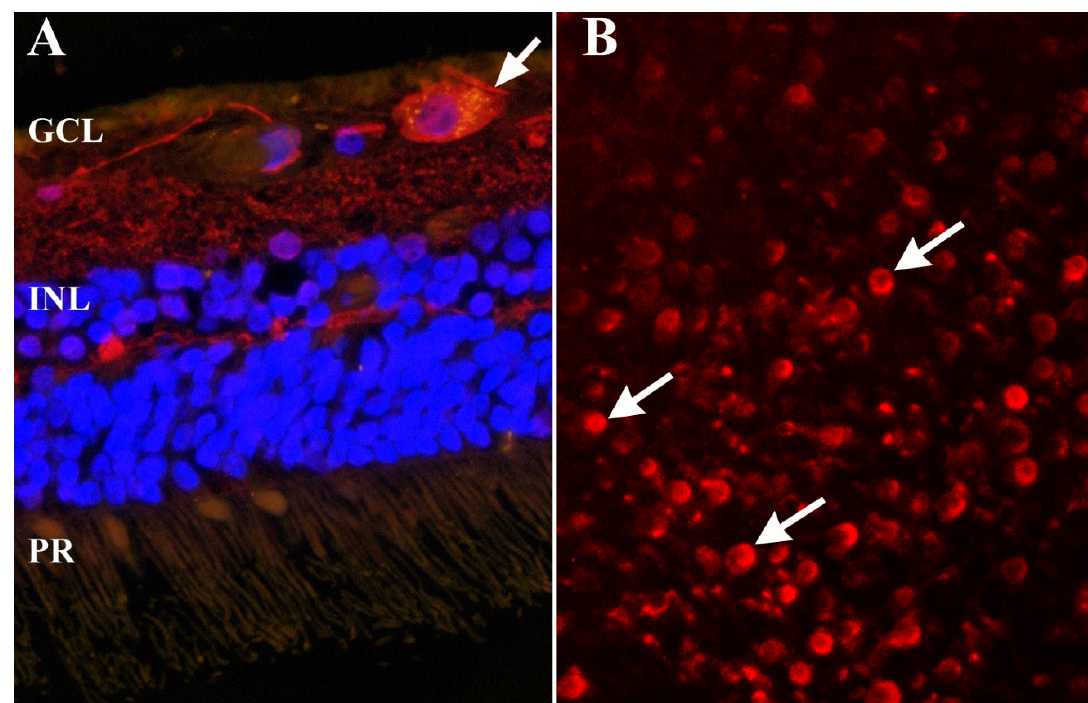
Figure 1. Formation of membrane attack complex (MAC) in the human retina. ( A ) Detection of the retinal ganglion cell (RGC) marker g-Synuclein (red) and MAC (green) in a sagittal section of a human glaucomatous retina. Deposition of MAC is apparent as yellow punctate labeling on the RGC (arrow) nuclei were labeled with DAPI (blue) to facilitate orientation. ( B ) Whole mounted retina of a second human eye with glaucoma. In some regions of this eye, MAC (red) could be detected in a large number of cells in the retinal ganglion cell layer (arrows). GCL: ganglion cell layer, INL: inner nuclear layer, PR: photoreceptor cells.